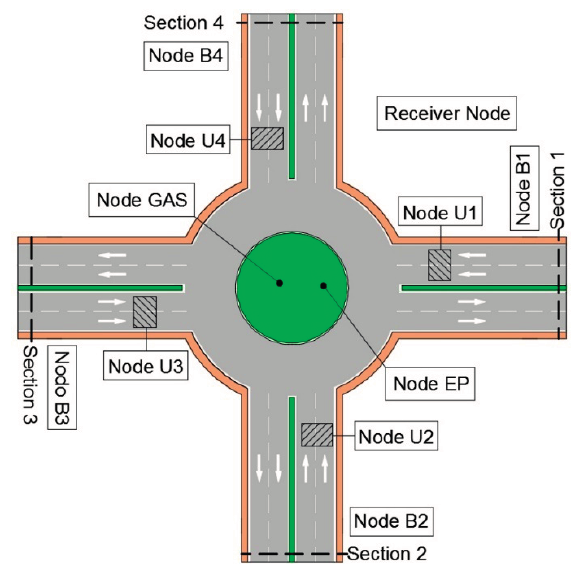
Figure 20. Experimental set up.